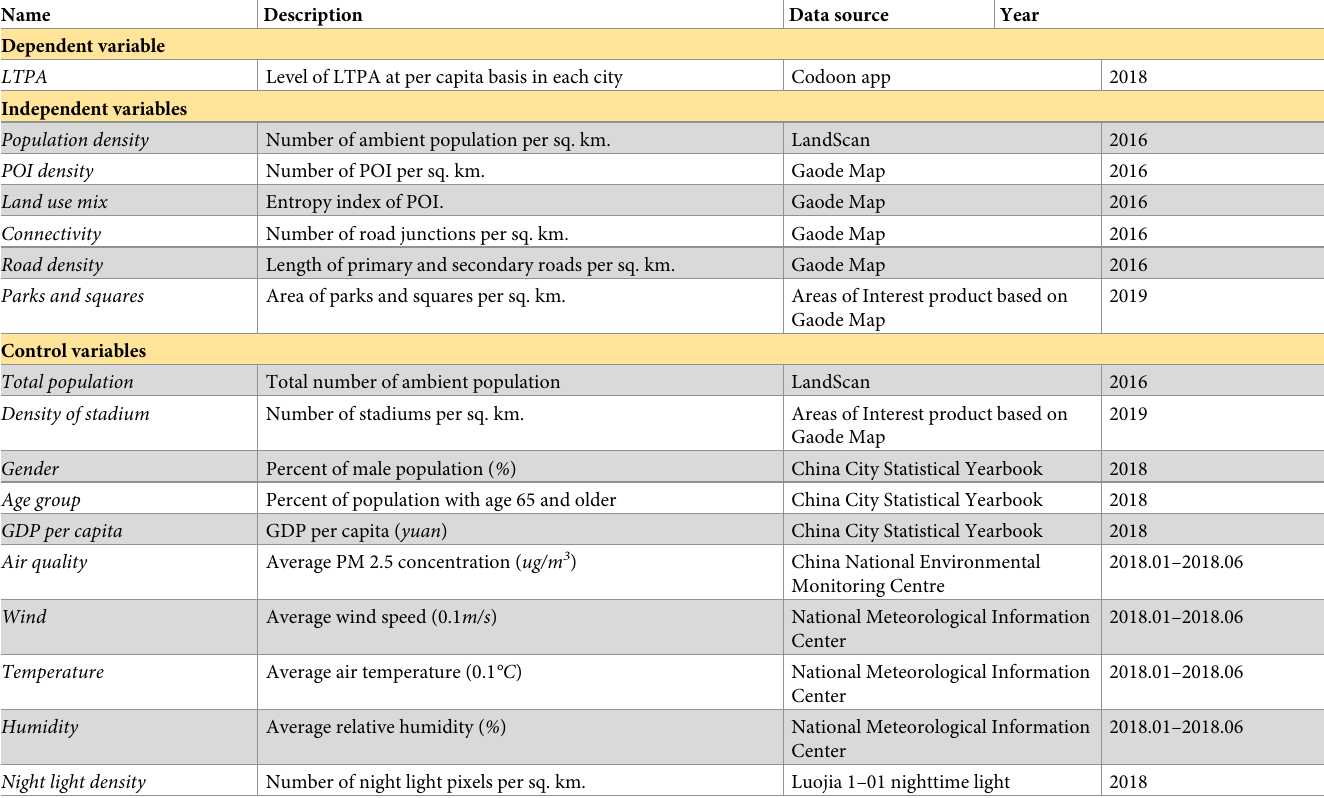
Table 1. A full list of dependent and independent